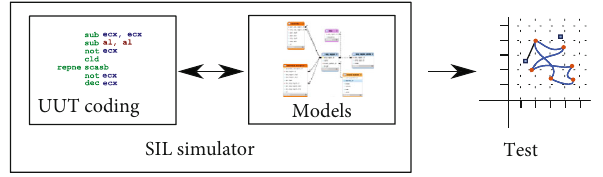
Figure 2: SIL veri fi cation